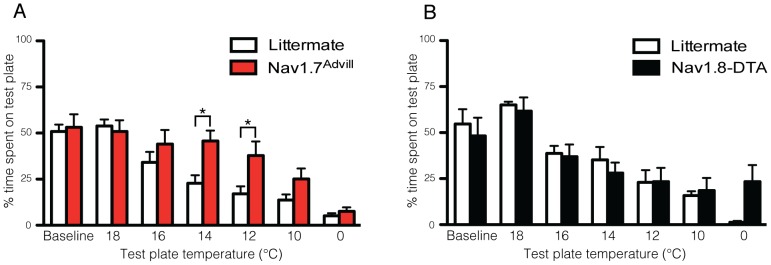
Comparison of different transgenic mice reveals distinct mechanisms underlie responses to cooling and noxious cold stimuli.(a) Nav1.7Advill mice (red columns, n = 8) avoid the 0°C test plate to the same extent as littermate controls (white columns, n = 8) in the thermal place preference test but show a behavioural deficit in the noxious cooling range (14–12°C). (b) Nav1.8-DTA mice (black columns, n = 6) avoid the cooling stimuli to the same extent as littermate controls (white columns, n = 6) in the thermal place preference test but show a trend indicating a behavioural deficit in response to 0°C. Data analysed by two-way analysis of variance followed by a Bonferroni post-hoc test. Results are presented as mean ± S.E.M. * P<0.05 (individual points).